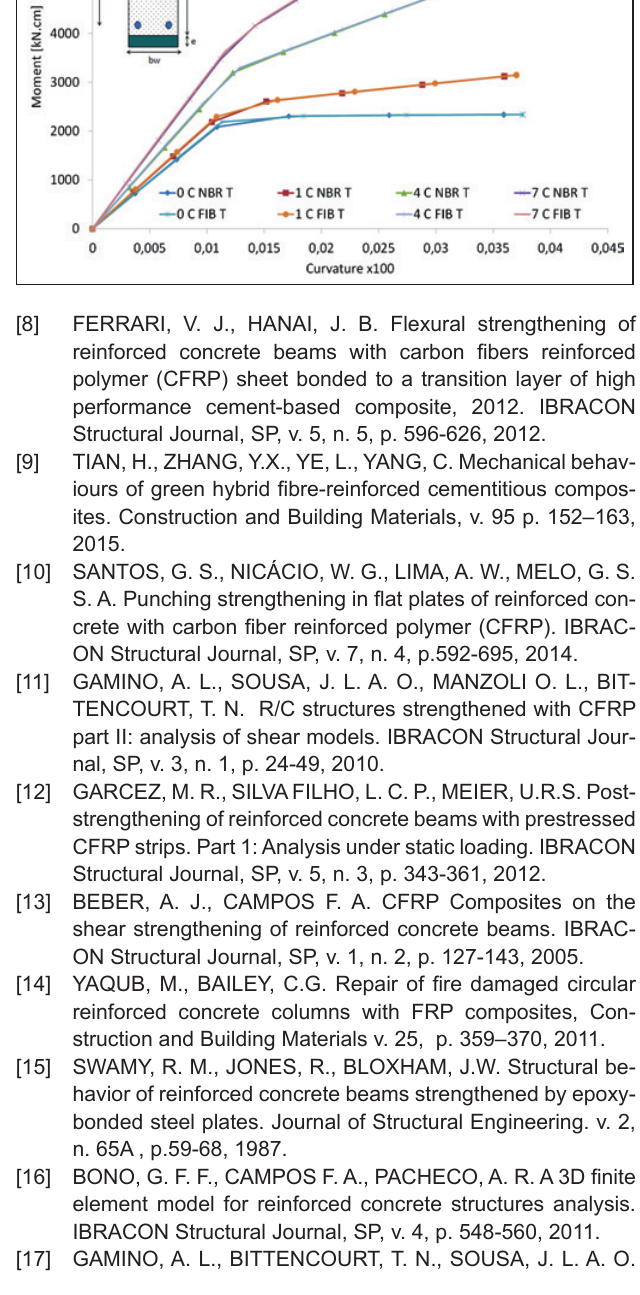
Figure 9 – Function moment - curvature for beams with rectangular cross section taking in comparison NBR-6118 and fib NBR code and rectangular cross section